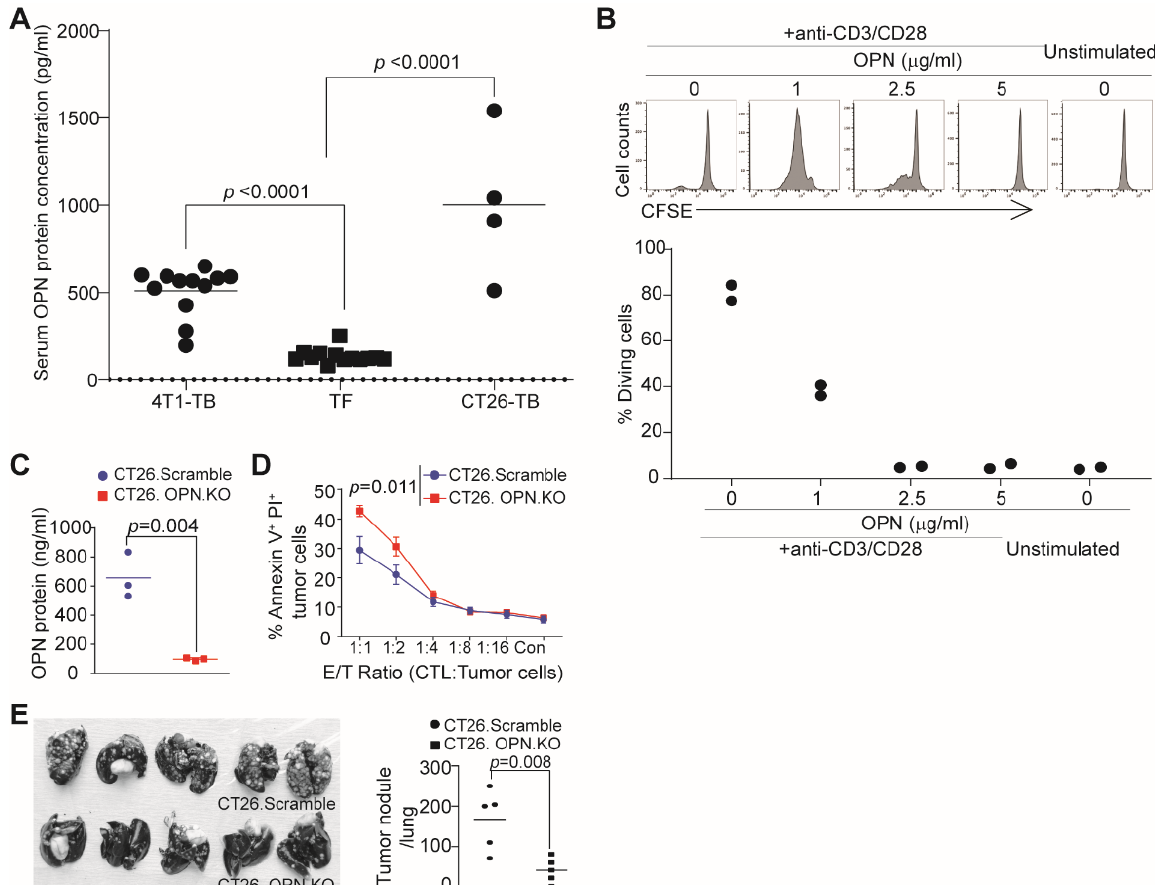
Figure 5. OPN inhibits tumor-specific CTL lytic efficacy and promotes colon tumor growth. ( A ) Serum specimens collected from tumor-free, 4T1 tumor-bearing, and CT26 tumor-bearing mice, and measured for OPN protein level by ELISA. ( B ) CFSE-labelled CD3 + T cells were cultured in anti-CD3 (8 g/mL) and CD28 (10 g/mL)-coated plates in the presence of the indicated coated OPN protein concentrations for 3 days. Cells were analyzed by flow cytometry. Shown is histograph of CFSE intensity (top panel) and quantification of T cell division (bottom panel). ( C ) CT26.Scramble and CT26.OPN KO cells were cultured for 24 h. Supernatants were collected and measured for OPN protein level. ( D ) CT26.Scramble and CT26.OPN KO cells were co-cultured with the tumor-specific CTLs for 24 h. Both floating and adherent cells were collected, stained with Annexin V and PI, and analyzed by flow cytometry. ( E ) CT26.Scramble and CT26.OPN KO cells (1 × 10 6 cells/mouse) were injected to BALB/c mice intravenously. Lungs were examined 14 days later for tumor nodules (left panel) and quantification of tumor nodules.